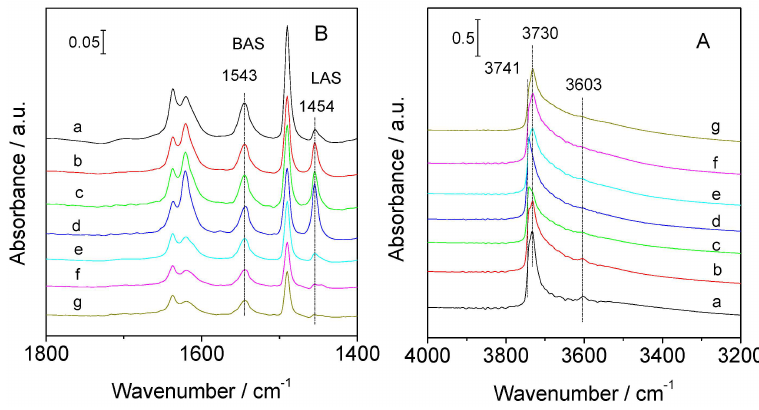
Figure 9. IR spectra of HB(77) ( a ); HB(77)-AT(0.05 M) ( b ); HB(77)-AT(0.1 M) ( c ); HB(77)-AT(0.2M) ( d ); HB(77)-AT(0.05 M)-NT(0.2 M) ( e ); HB(77)-AT(0.05 M)-NT(1 M) ( f ); and HB(77)-AT(0.05 M)-NT(2 M) ( g ) catalysts before ( A ) and after ( B ) pyridine was absorbed and then desorbed at 423 K for 1 h.